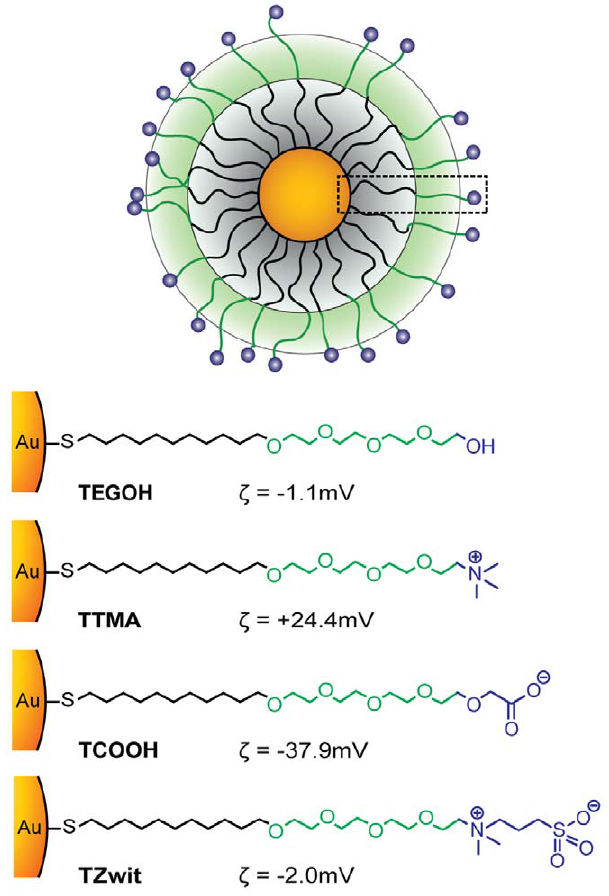
Figure 1. Structural representation of gold nanoparticles (2 nm core diameter) used. Gold nanoparticles (AuNPs) of different surface charges were generated by chemical modification of the terminal portion of the ligand bonded to the nanoparticle core. Four types of AuNPs were used neutral (TEGOH), positive (TTMA), negative (TCOOH) and zwitterionic (TZwit). The surface charge was measured by zeta potential.